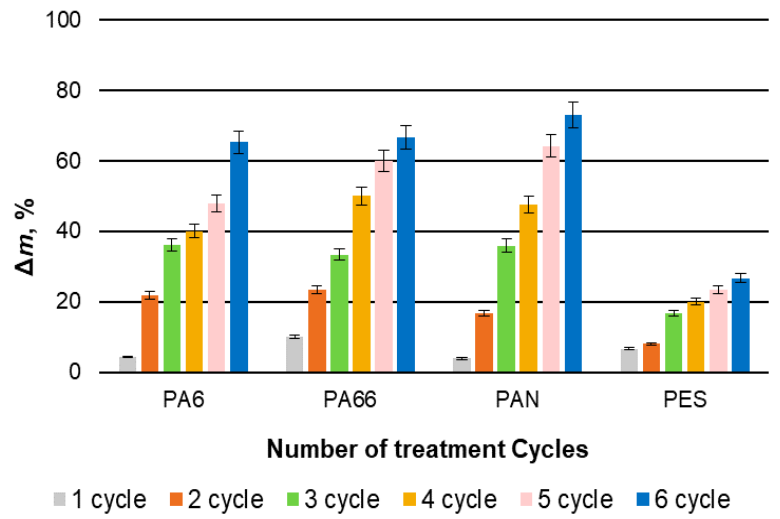
Figure 4. Variation in the mass of the investigated synthetic fibers during the process of modification with copper selenide.